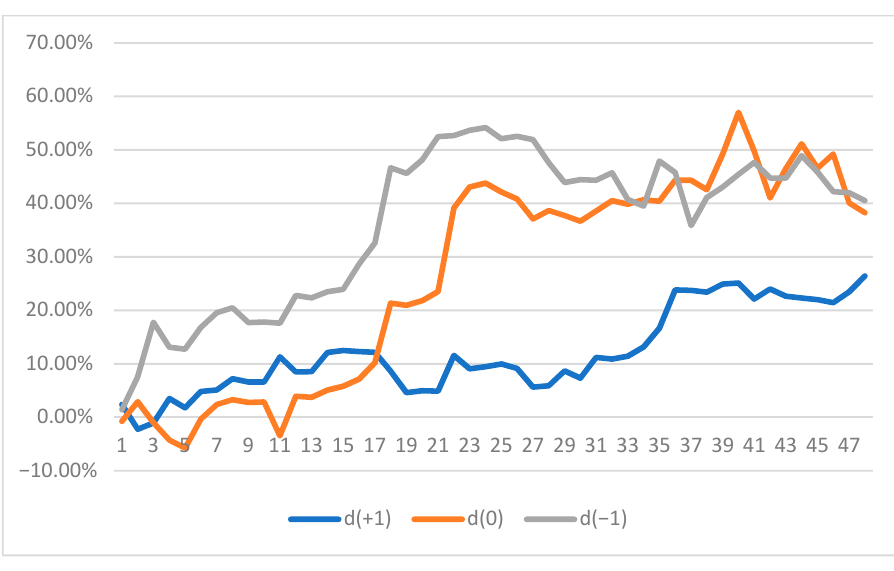
Figure 1. Trading simulation results of the expiration day price effects: daily data.